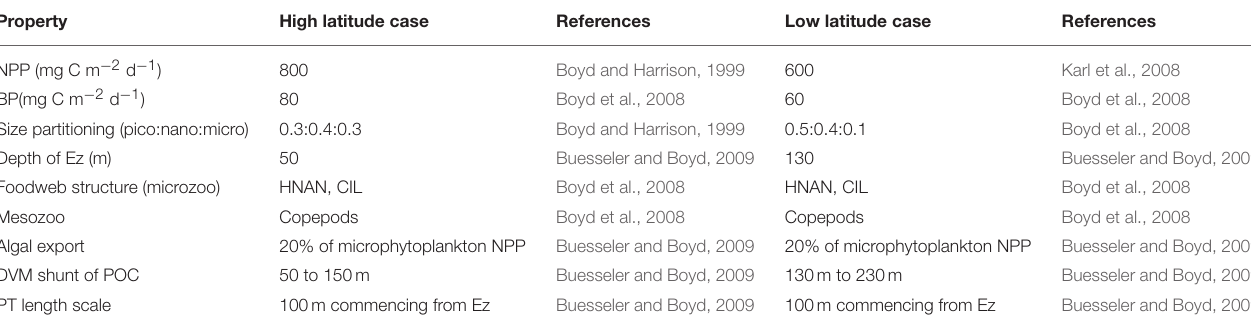
TABLE 2 | Details of the standard runs for the representative cases for the high (HNLC subpolar waters, Boyd and Harrison, 1999; Boyd et al., 2008) vs. low (LNLC subtropical waters, Karl et al., 2008; Boyd et al., 2008) latitude ocean. Property